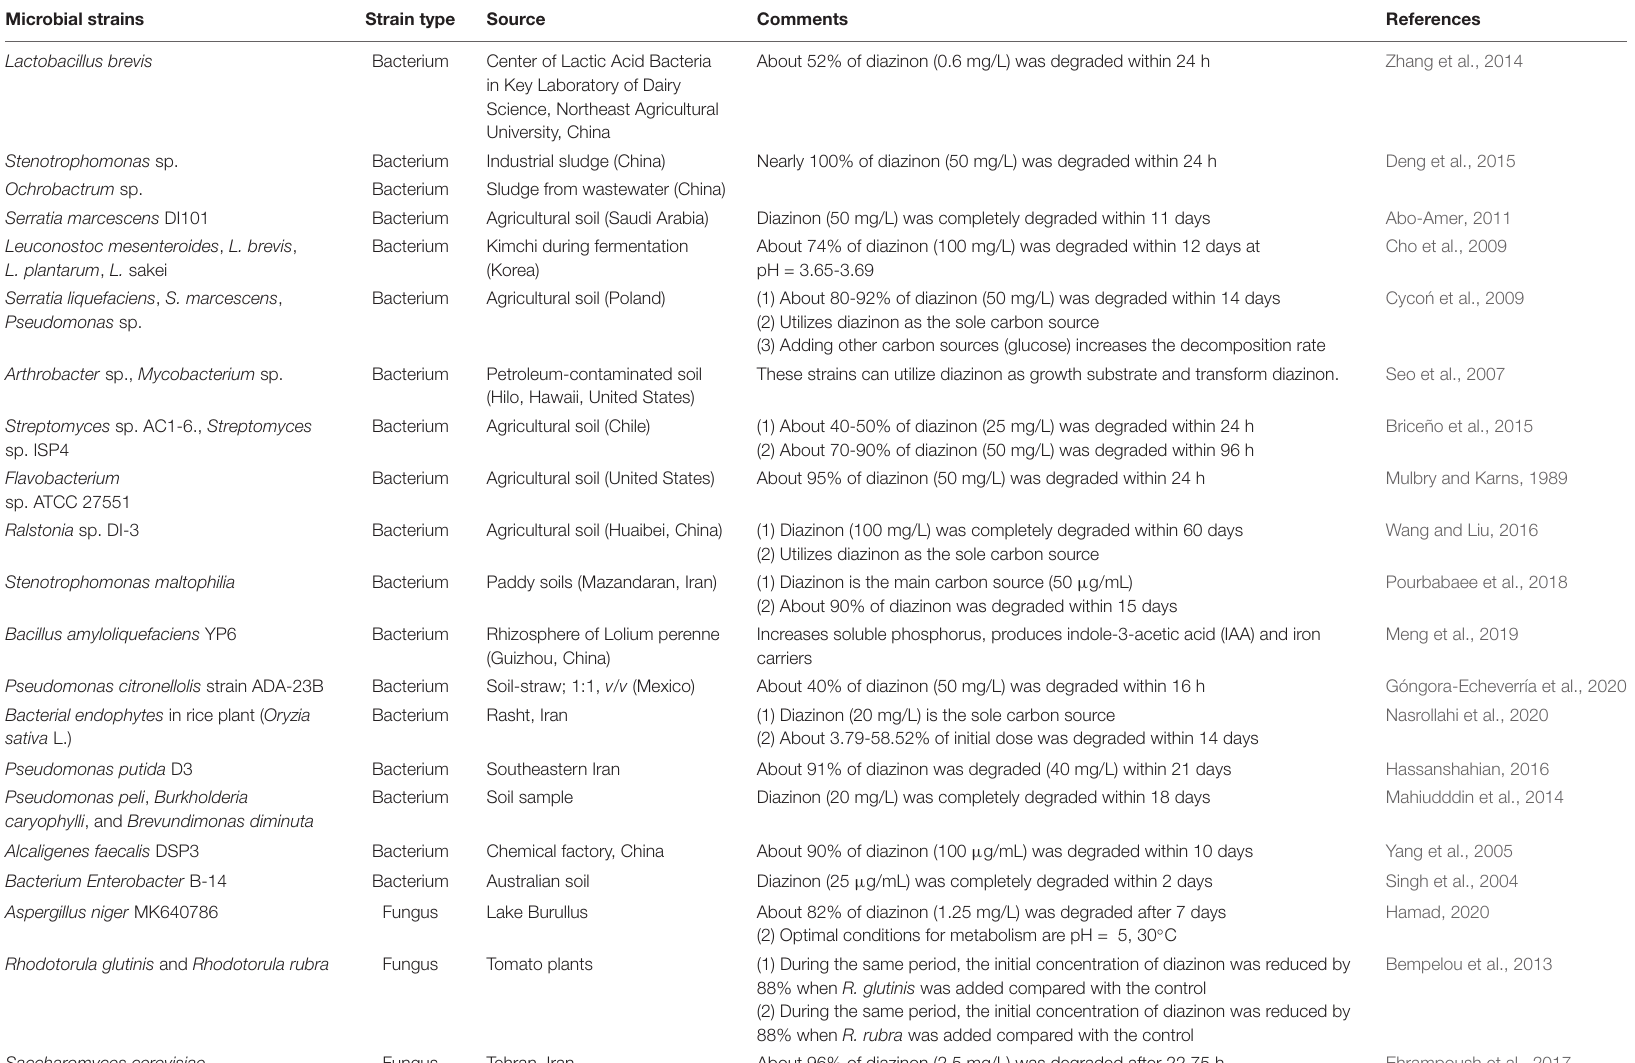
TABLE 3 | Indigenous microbial strains involved in diazinon